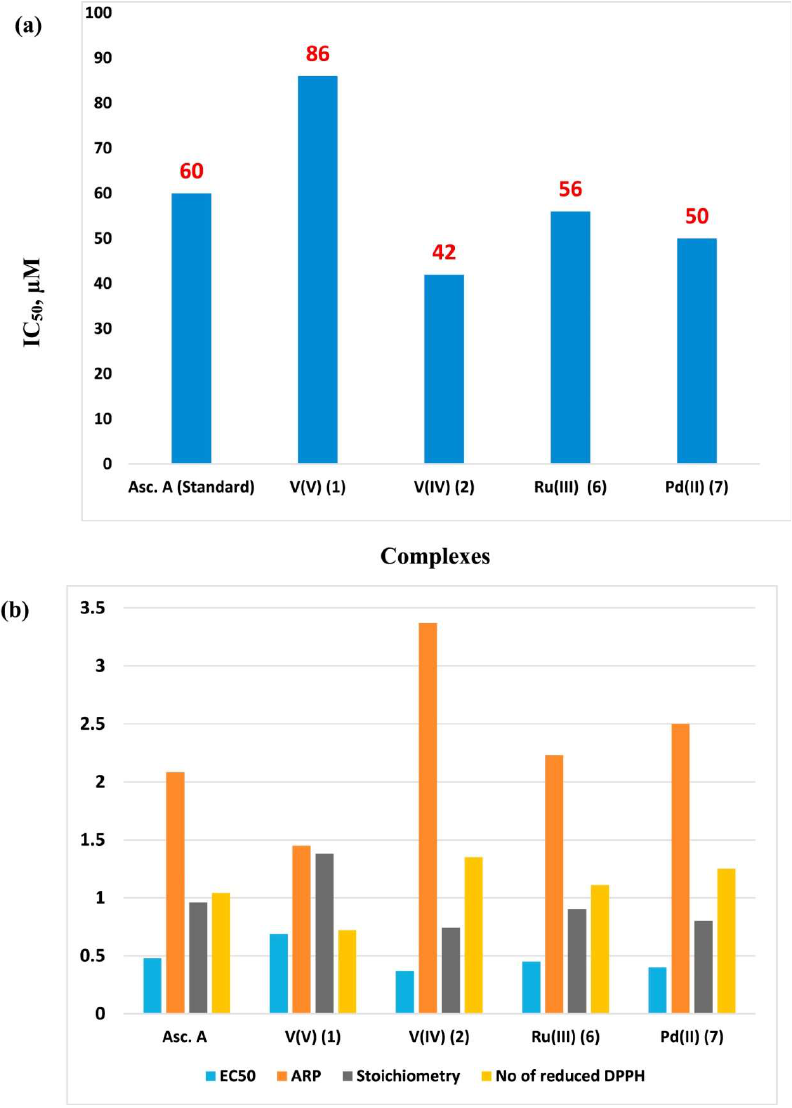
Figure 15. Antioxidant performance of studied compounds (103) [VO 2 (Hdhbh)], (104) [VO(phen)(dhbh)]∙1.5H 2 0, (108) [Ru(PPh 3 ) (dhbh)Cl (H 2 O)] and (109) [Pd(Hdhbh)Cl] estimated through DPPH radical test associated to ascorbic acid as a reference for ( a ) IC 50 & ( b ) other antioxidant factors. Reproduced from the permission of ref. [159].